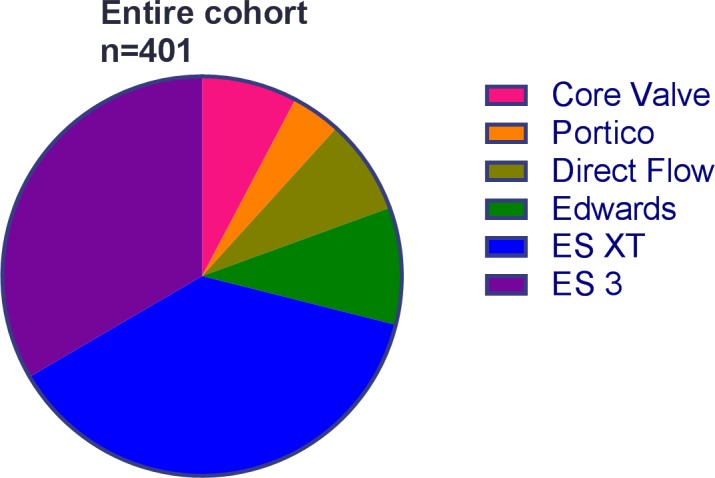
Distribution of the different valve types in the entire cohort (n = 401).